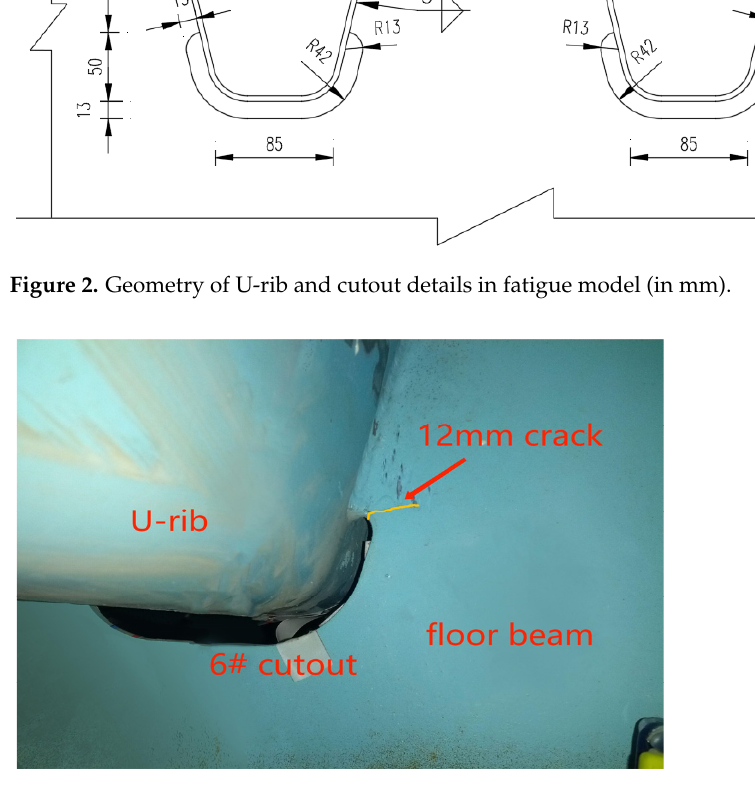
Figure 3. Cutout fatigue crack in the fatigue test model.